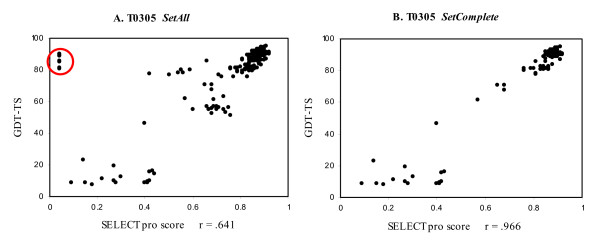
SetAll versus SetComplete. Plots of SELECTpro scores versus GDT-TS scores for T0305 models from SetAll (A) and SetComplete (B). The Pearson correlation is .641 for SetAll and .996 for SetComplete. This large difference is mainly due to the extended chain models (circled in plot A) scored by SELECTpro due to an error in our use of Modeller to generate complete models from incomplete ones.